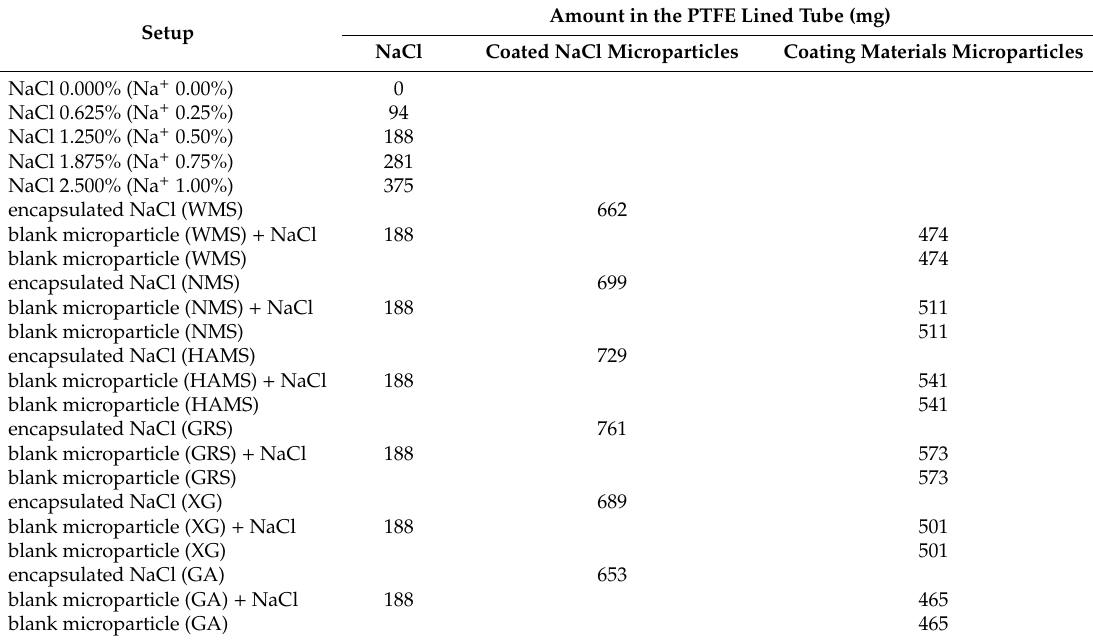
Table 1. The formulations used to prepare the model systems in a PTFE-lined tube a.